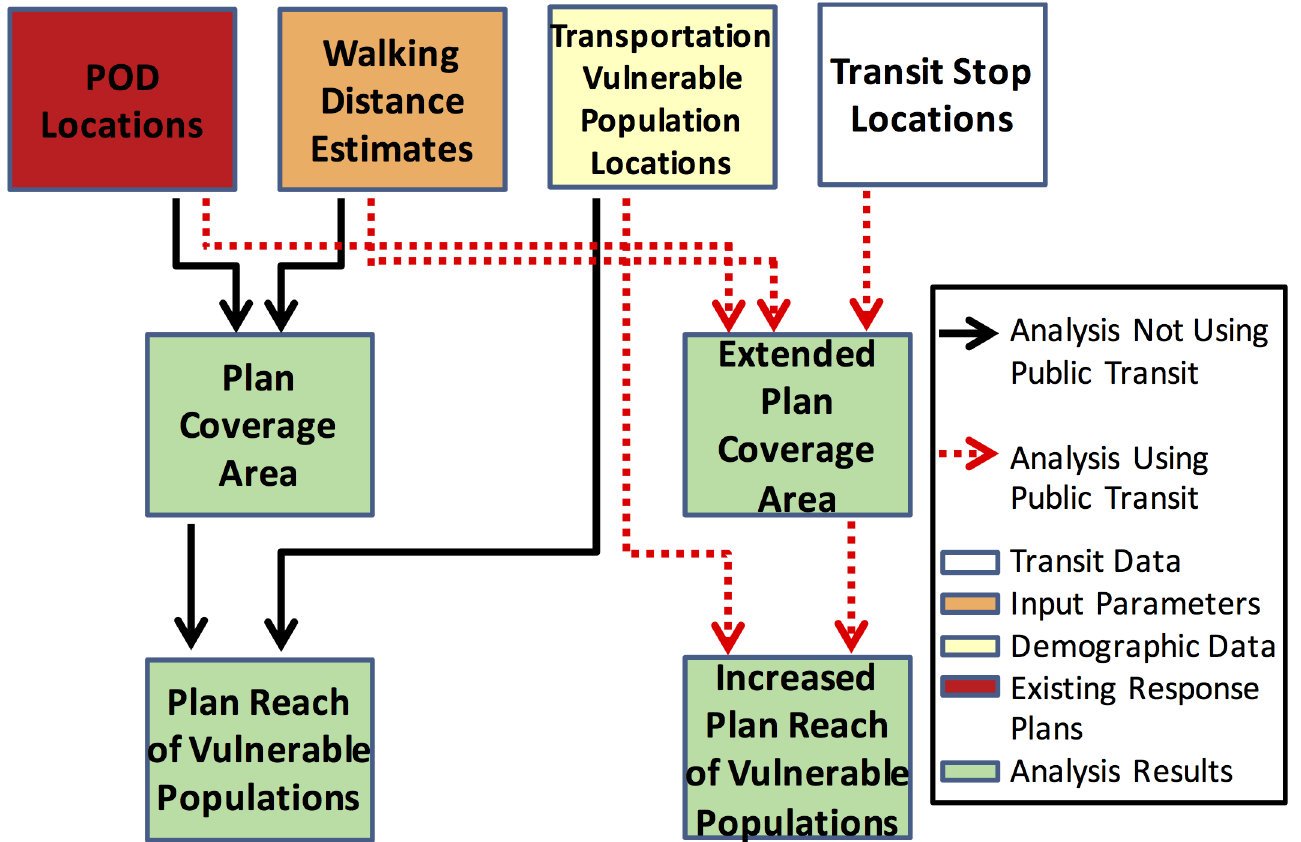
Fig 2. Type-1 Quantification: Summary. Summary of Type-1 transportation vulnerability quantification and analysis.